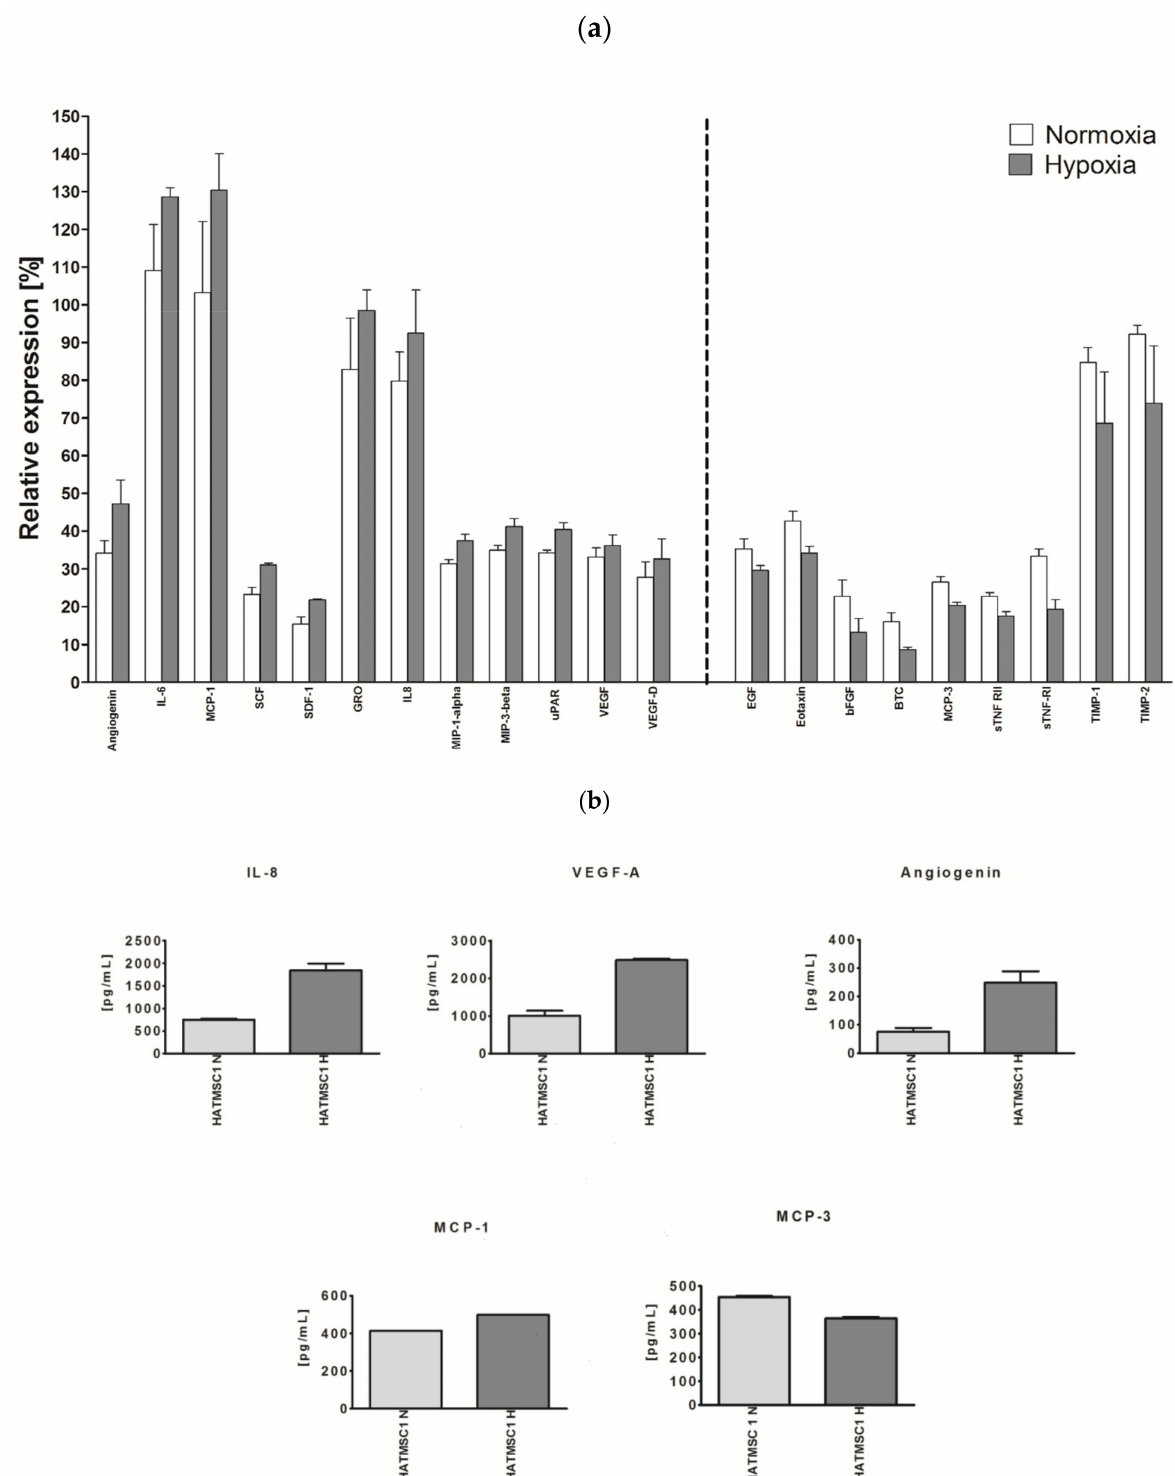
Figure 6. Selected cytokine production as a function of culture under normoxic and hypoxic conditions. ( a ) The secretory profile of the tested line was determined using the RayBio C-series Human Cytokine Antibody Array for a panel of 120 cytokines and expressed as a histogram relative to a positive control. The data represent the mean from a duplicate assessment +SEM. ( b ) Changes in the five selected cytokines levels were confirmed and quantified (for normoxic and hypoxic condition similar to that in ( a ) using the Multiplex ELISA method, Human Cytokine/Chemokine Magnetic Bead Panel MILLIPLEX ® MAP Kit (Merck, Darmstadt,